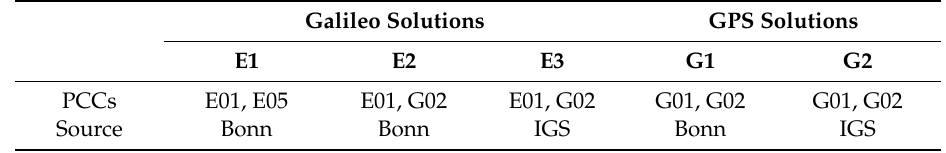
Table 1. Solution types prepared for the DD and PPP approaches. For each solution receiver, the antennas were modeled using di ff erent sources of the